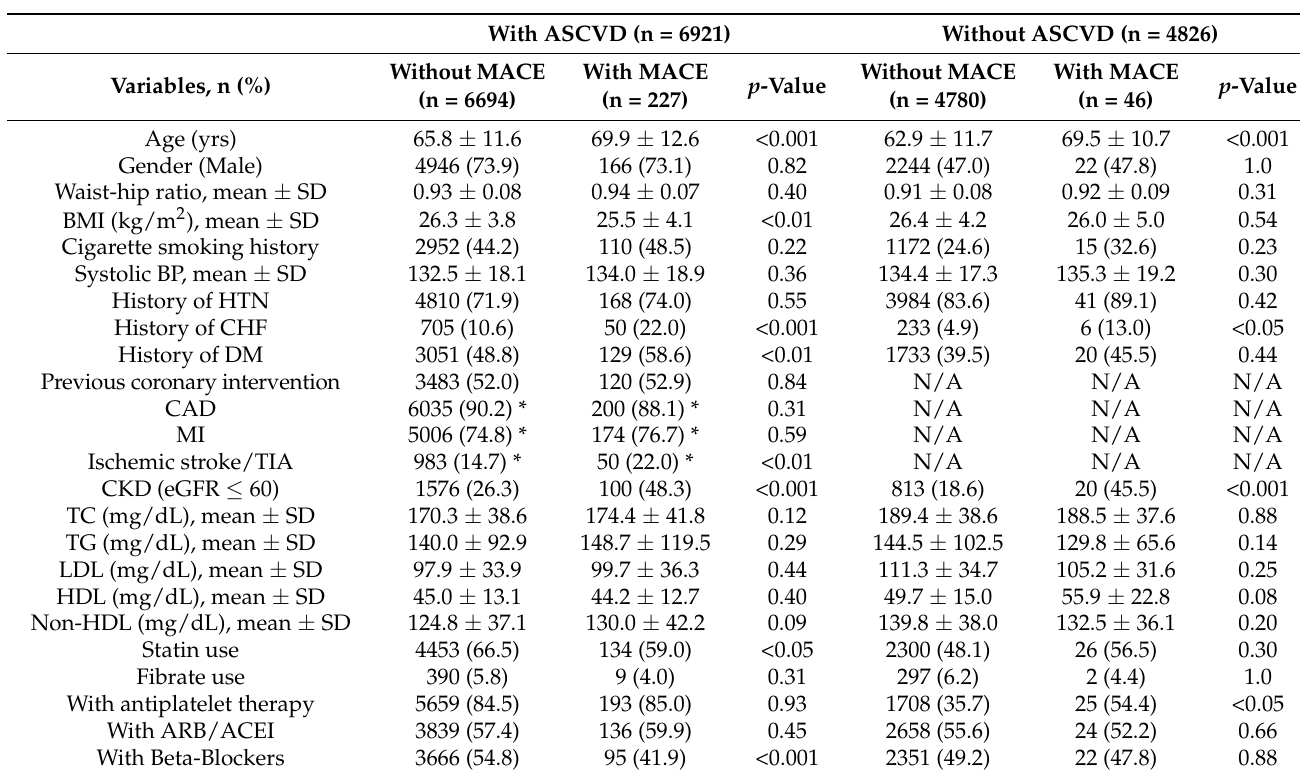
Table 2. Baseline characteristics of individuals by primary outcome events among patients with and without